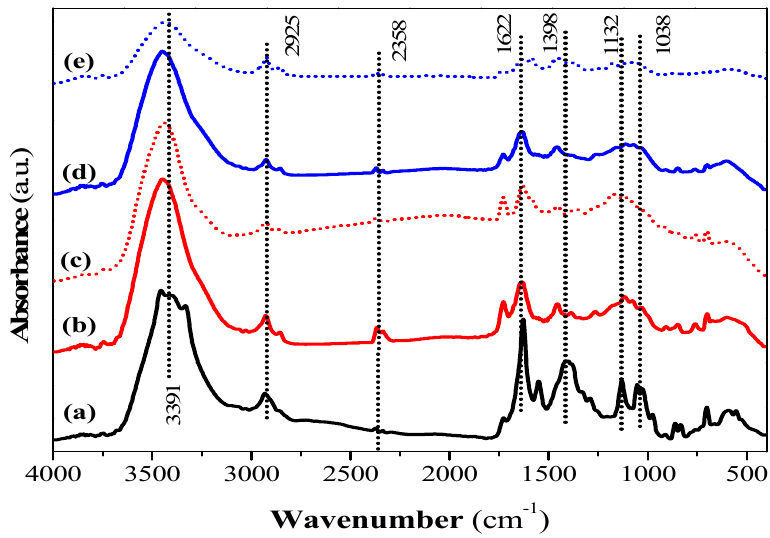
Figure 6. FT-IR spectra of QS-P ( a ), QS-CO 2 ( b ), QS-CO 2 CV ( c ), QS-H 2 O ( d ), and QS-H 2 O CV ( e ). XRD patterns of QS-P, QS-CO 2 , QS-H 2 O, CQW-P, CQW-CO 2 , and CQW-H 2 O are